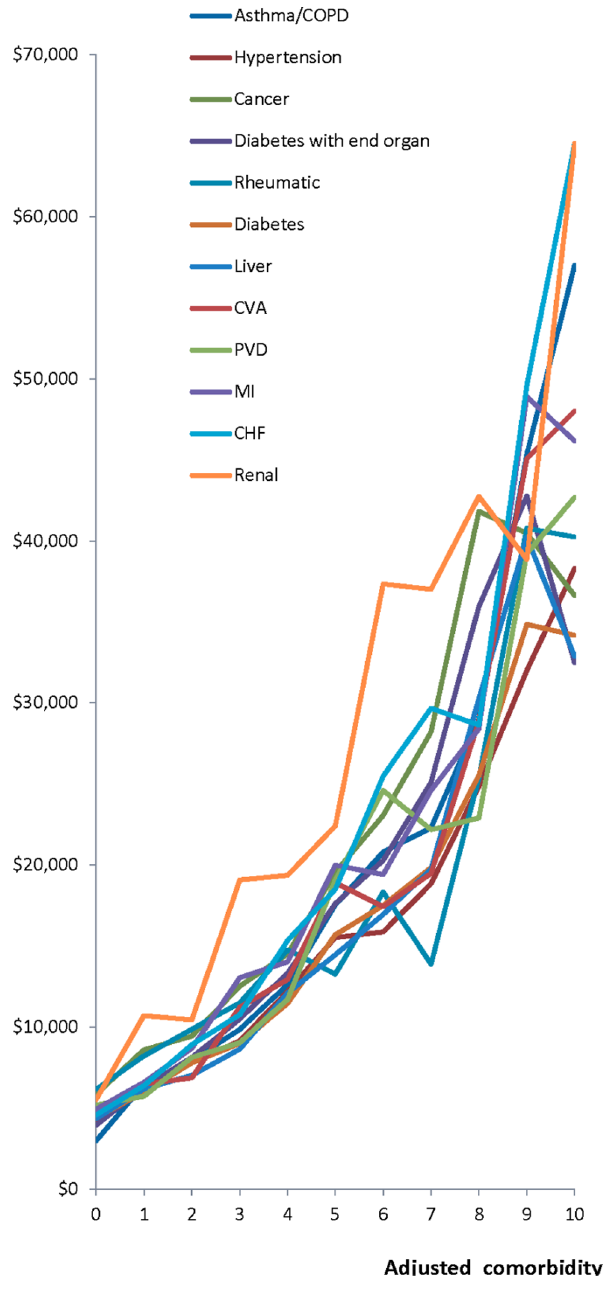
Figure 2. The y-axis is total costs, that is, the total yearly costs for patients with that disease according to the comorbidity level. The x-axis is the adjusted comorbidity index found by subtracting the weight of each disease from the patient’s comorbidity index for those patients with the stated disease . Thus, a patient with an adjusted comorbidity index of 0 has only that chronic disease.